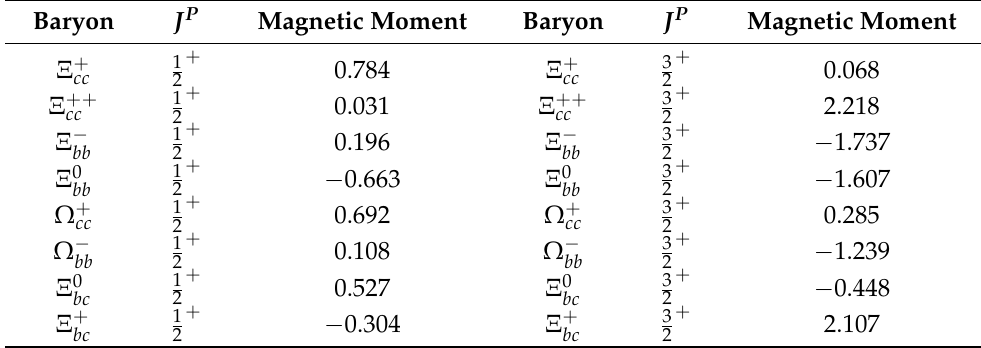
Table 5. The magnetic moments of doubly heavy baryons (in terms of nuclear magnaton µ N ). Baryon J P Magnetic Moment Baryon J P Magnetic